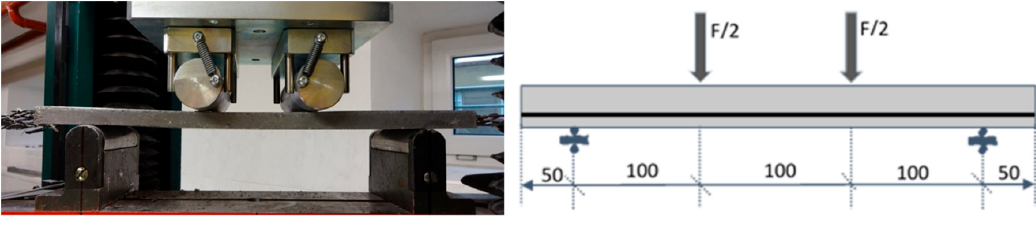
Figure 4. Four-point bending test for the BRG specimens.